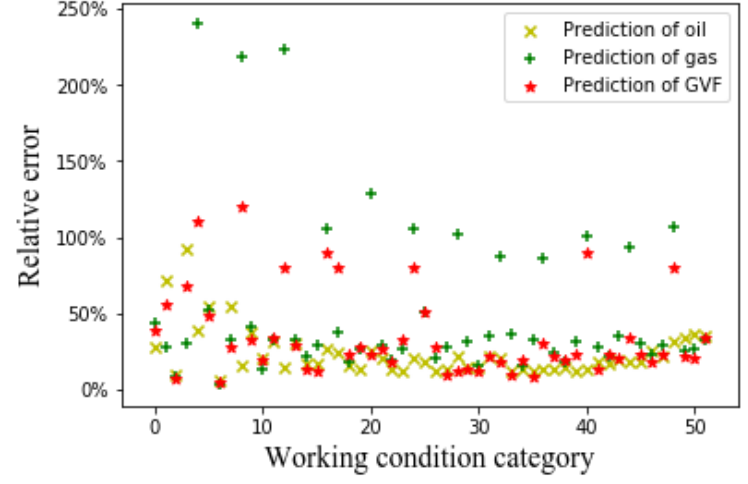
Figure 12. Relative error of SVM algorithm based on original capacitance value.